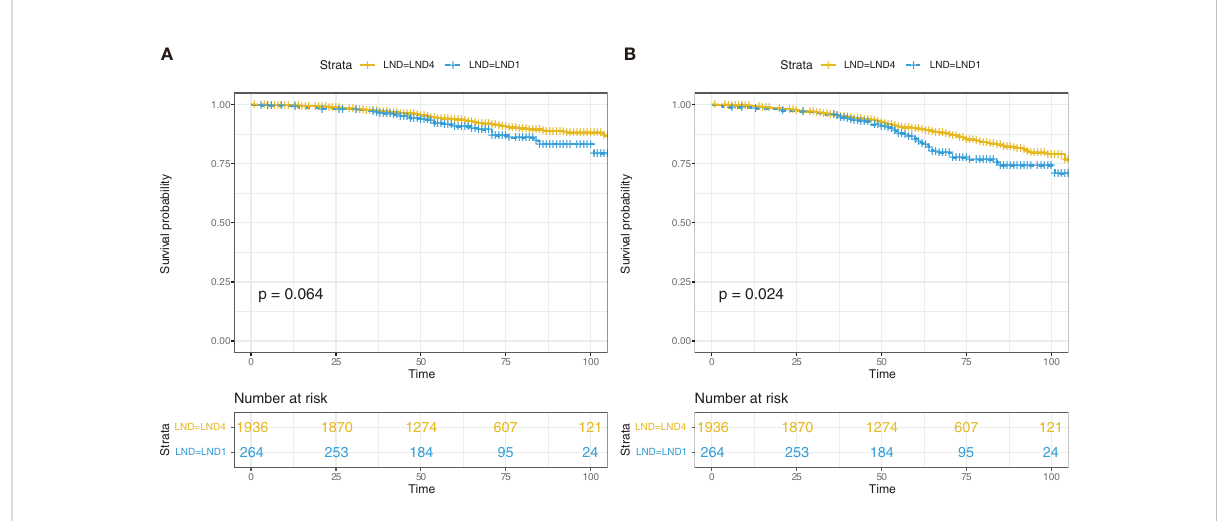
FIGURE 1 Kaplan – Meier estimated of cancer-speci fi c survival (CSS) (A) and overall survival (OS) (B) in the pN1 patients who received radical prostatectomy and lymph node dissection according to one to three regional lymph nodes (LND1) or four or more regional lymph nodes (LND4).